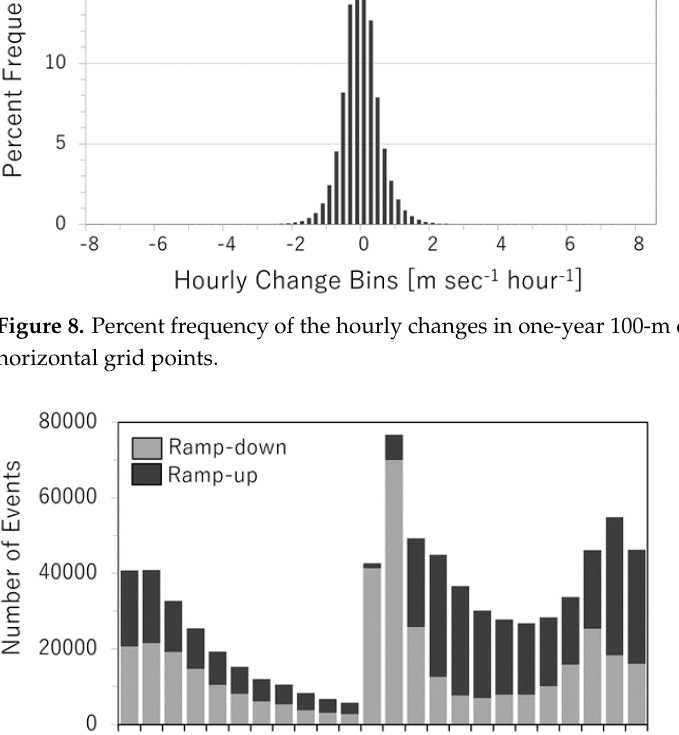
Figure 10. Spatial distribution of hourly frequency of the 0.1% most extreme ramp-down events at each grid point (shaded). The contours indicate terrain heights (100-m intervals).